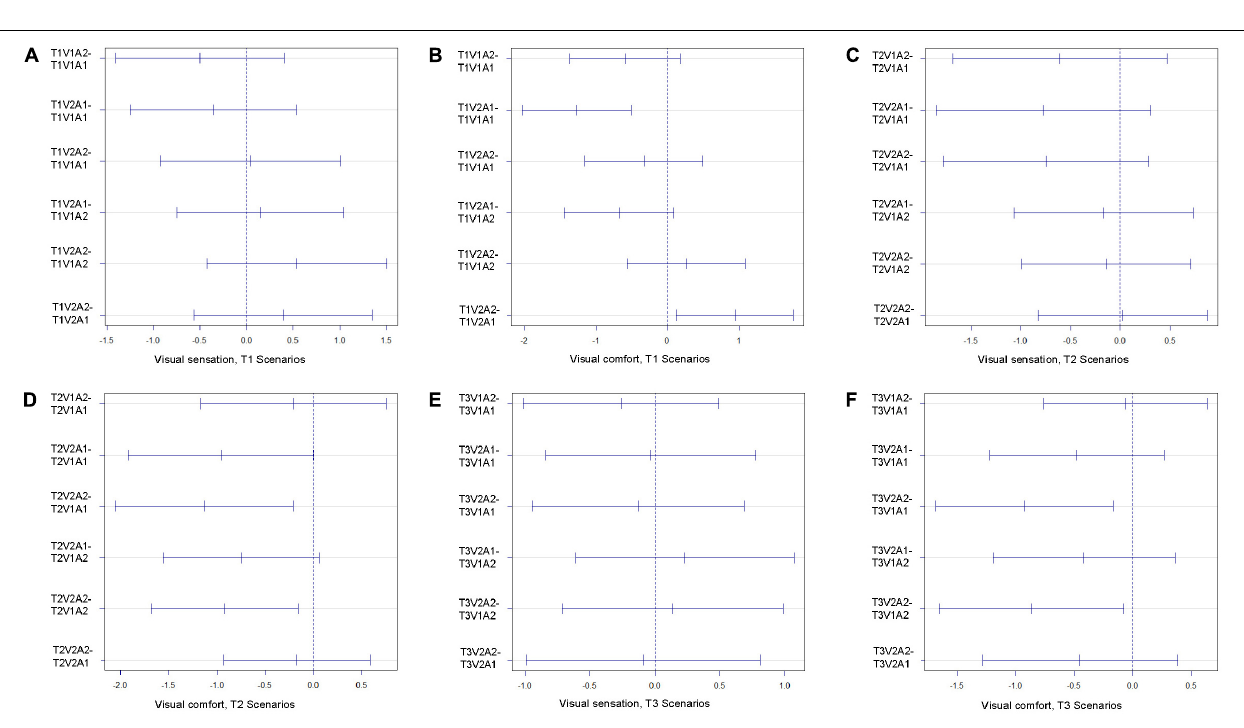
Frontiers in Built Environment |